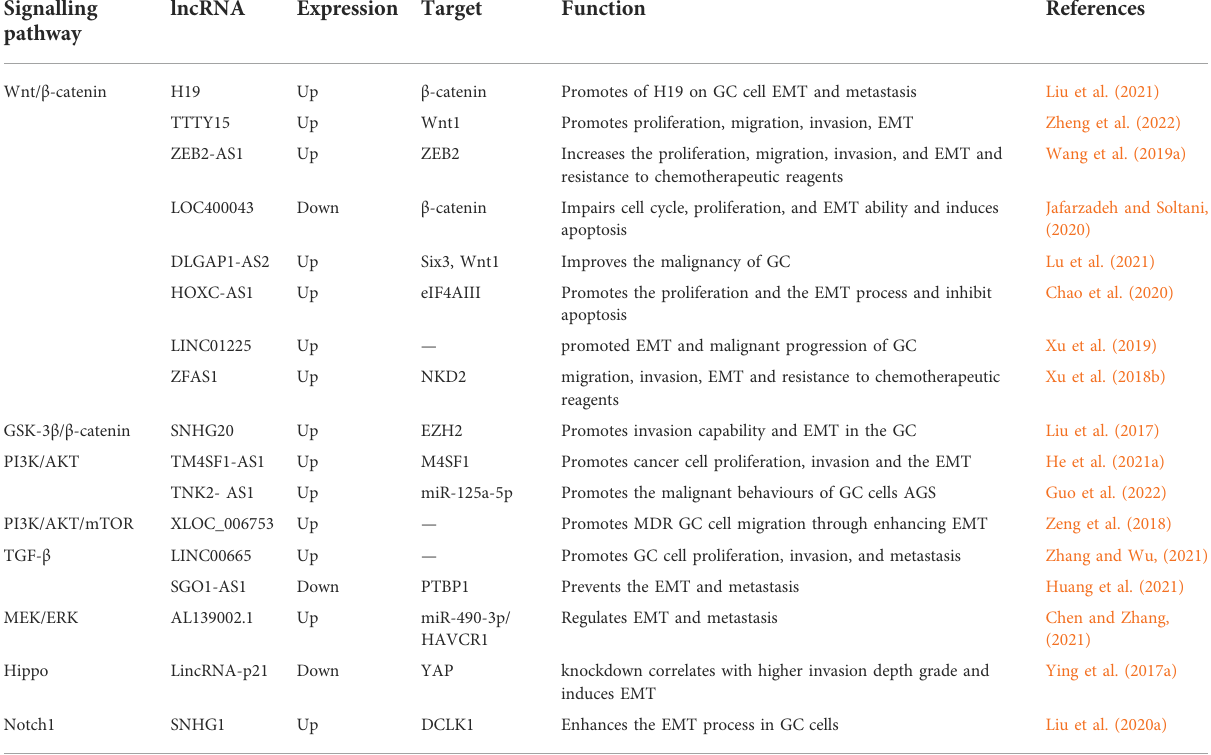
TABLE 1 LncRNAs and their targeting signalling pathways in the regulation of EMT-induced GC metastasis. Signalling